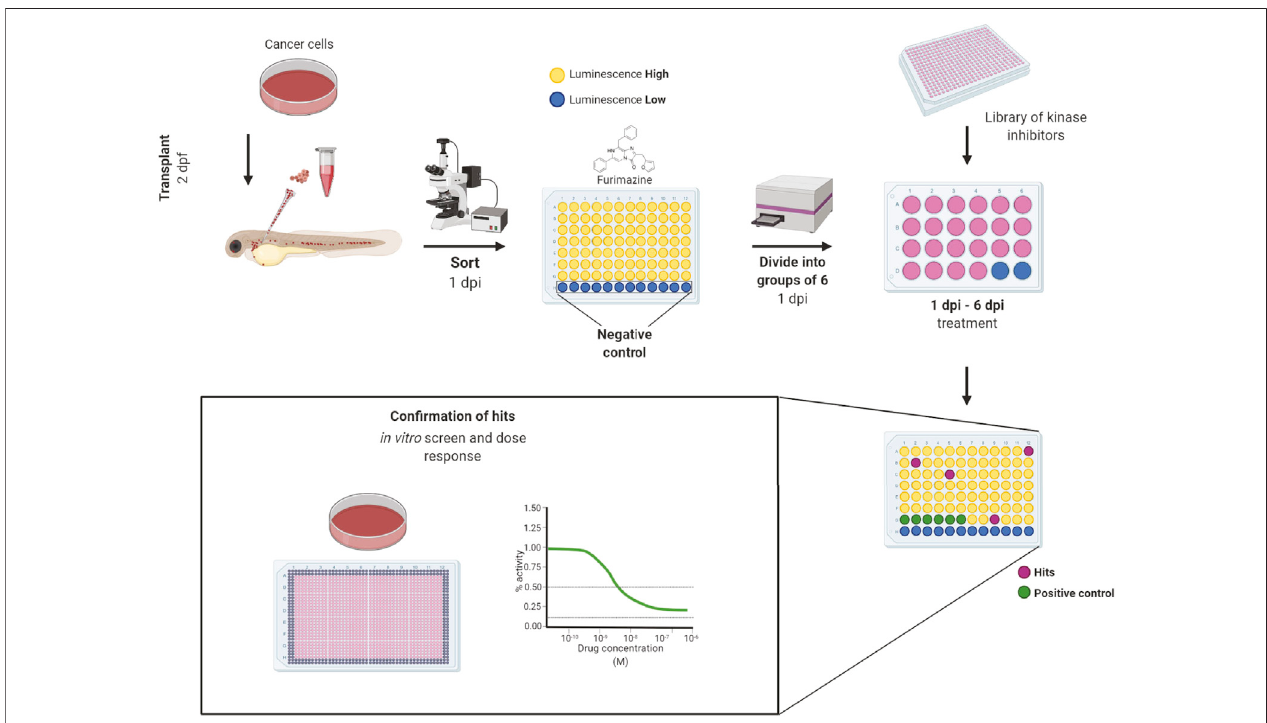
FIGURE2| Work fl owof invivo small-moleculeusingbioluminescencescreeningplatform.Thework fl owof invivo small-moleculescreeningstartedwithcancercell transplantation into 2 days post-fertilization (dpf) zebra fi sh embryos. The transplanted embryos were washed and kept in incubator overnight. At day 1 post-injection (dpi)theembryosweresortedaccordingto fl uorescenceunderanOlympusmacroscopeandweredividedintowellsofa96-wellsolidwhiteplate.Uninjectedembryosin E3waterandE3waterwithoutembryoswereusedasnegativecontrolstodeterminethebackgroundlevelofluminescence.Luciferaseassaywascarriedoutusing the Furimazine substrate by adding it into all wells equally and the luminescence was measured after 10 min of incubation on the EnVision plate reader. After the measurement, embryos were recovered, washed and randomly divided into groups of 6 animals into 24-well polystyrene plates, where they were treated by inhibitors fromalibraryofkinaseinhibitorsatthe fi nalconcentrationof10 µMandDMSOwasusedasnegativecontrol.Weuseddabrafenibandimatinibaspositivecontrols.Atthe end of the experiment, at 6 dpi, the luminescence of whole embryos was measured again to determine the cell growth or its inhibition. The lower the fi nal luminescence, comparedtopositivecontrolstreatedwithDMSO,thestrongeristheinhibitoryeffect.Finally,thecompoundscanbeanalyzed invitro todeterminedoseresponsecurves and to compare the in vitro vs. in vivo effectivity. Figure created in